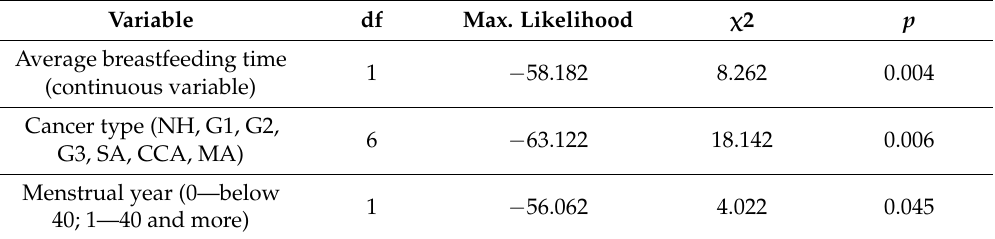
Table 2. Model of relations between the AMH protein expression (modeled probability = 1) and studied variables; the best flitted model using the AIC (Akaike information criterion) (AIC = − 128.102; df = 9; χ 2 = 27.795; p = 0.001). Variable df Max. Likelihood χ 2 p Average breastfeeding time (continuous variable) 1